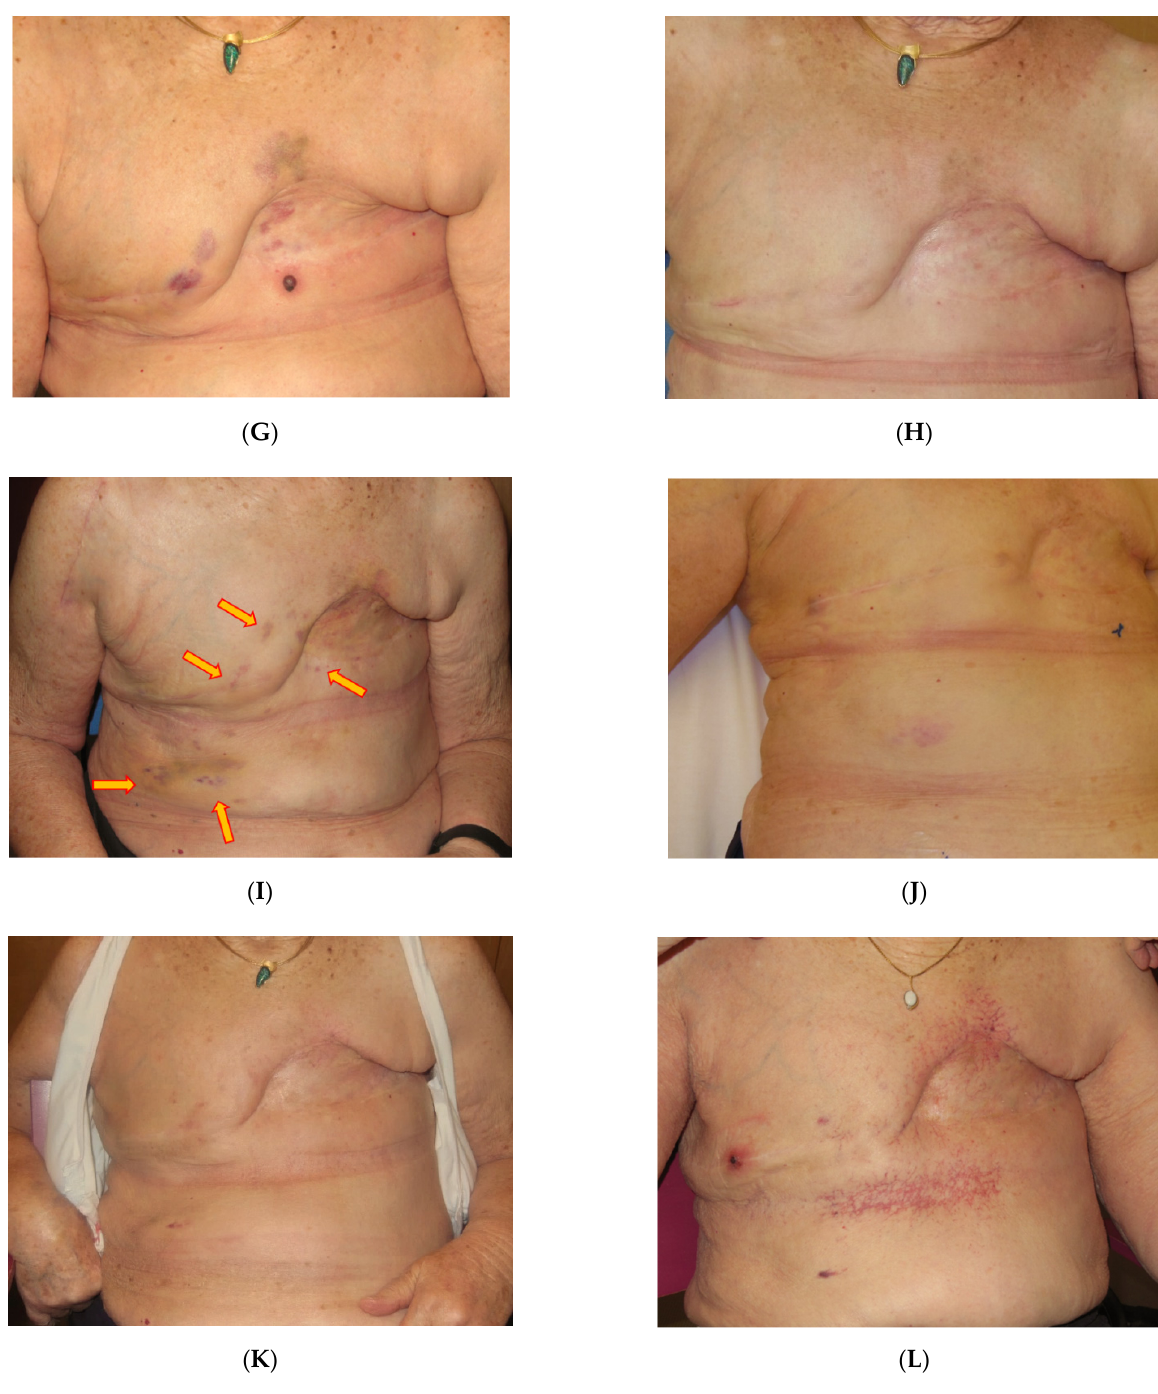
Figure 4. Successive photo documentation of patient No. 4: ( A ) 1st RAASB recurrence (March 3, 2017), after mastectomy 2015 . ( B ) Postoperative situation including skin reconstruction with mesh graft, R1, and contralateral mastectomy (March